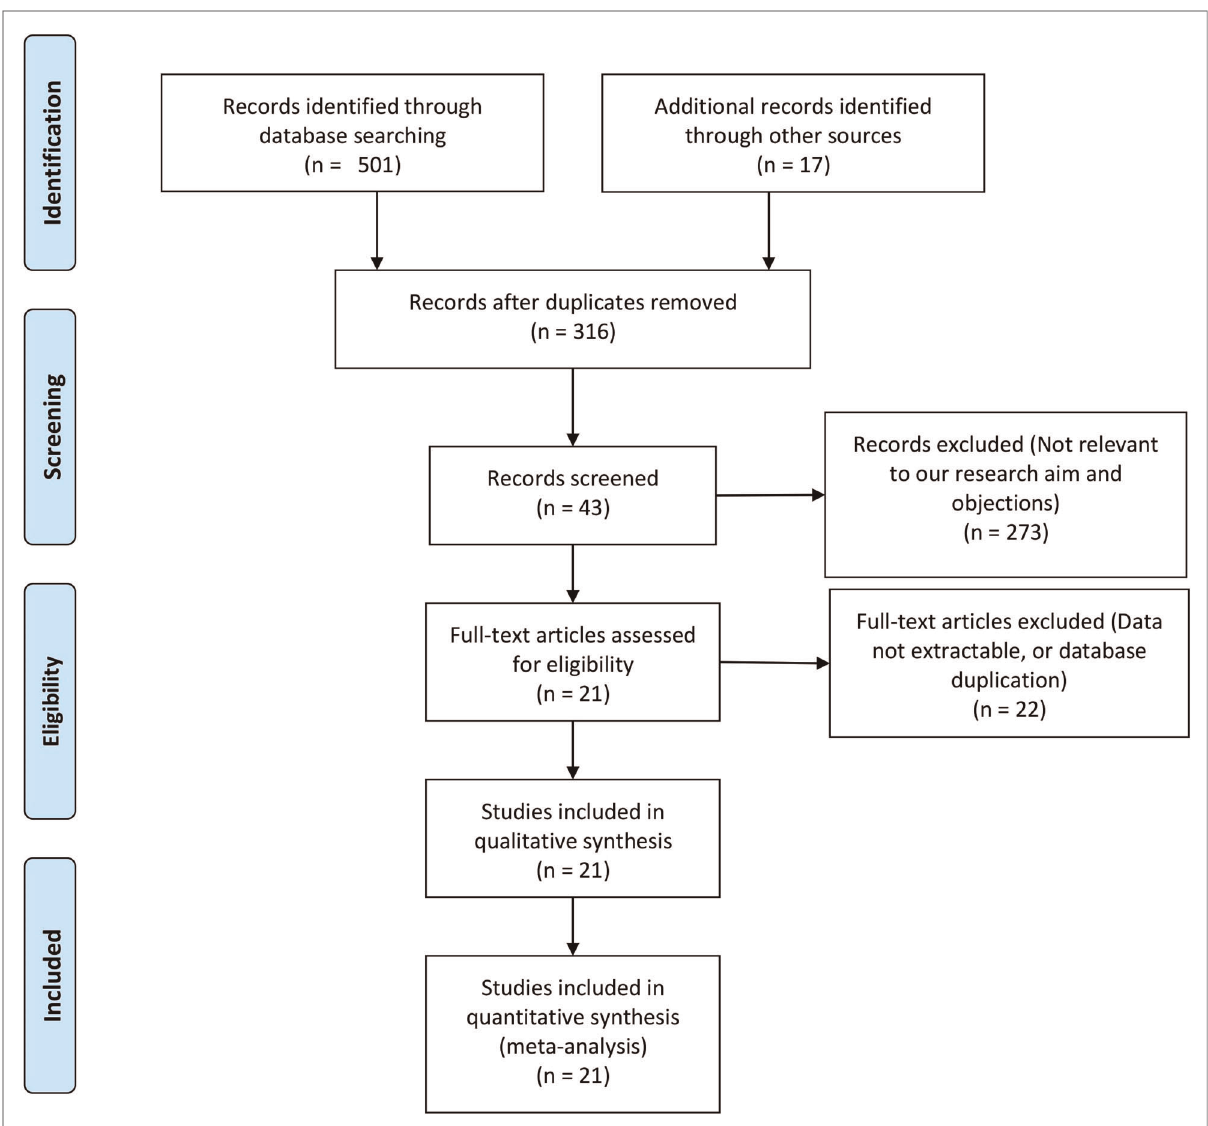
FIGURE 1 Flow diagram of the selection